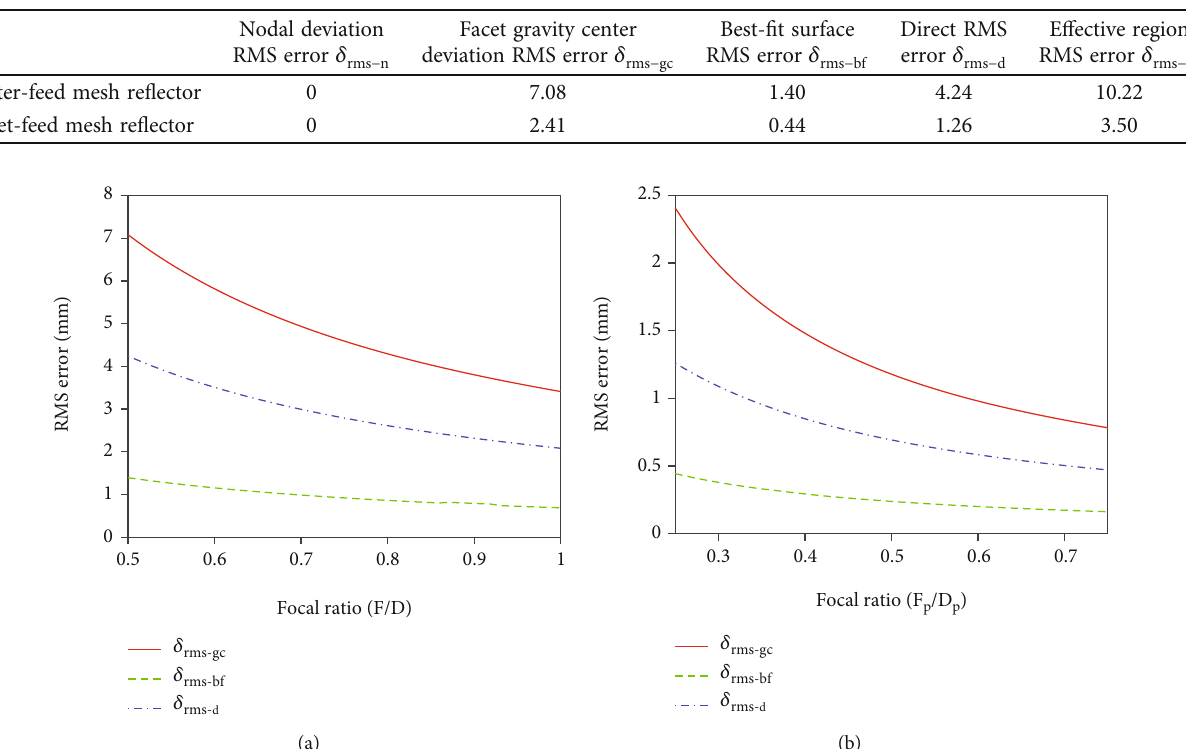
Figure 16: Top view of the two mesh re fl ectors with 127 nodes: (a) the center-feed mesh re fl ector and (b) the o ff set-feed mesh re fl ector. Table 3: Comparison of di ff erent RMS error calculation methods (mm).